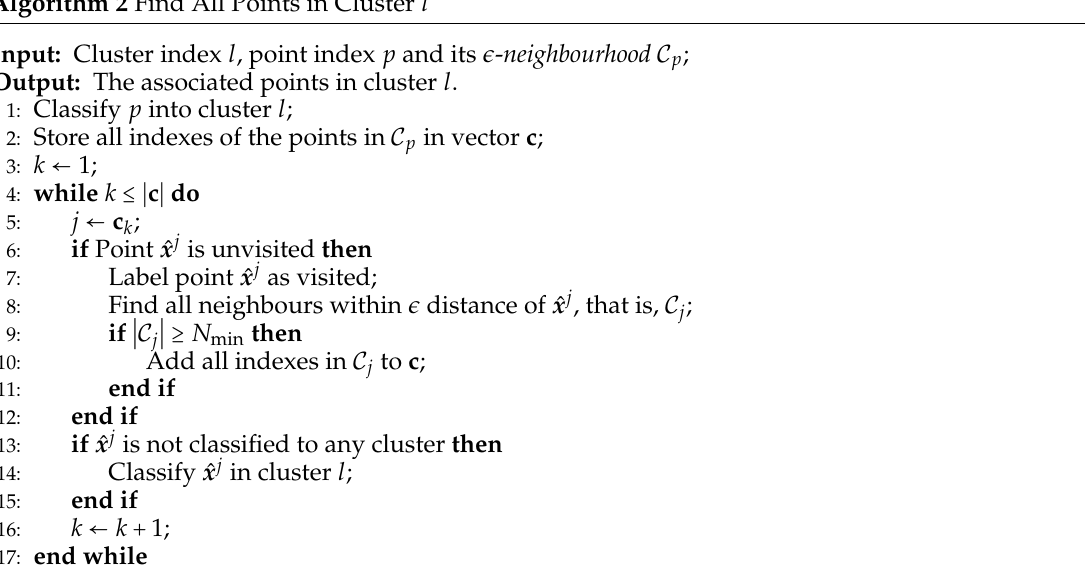
Algorithm 2 Find All Points in Cluster